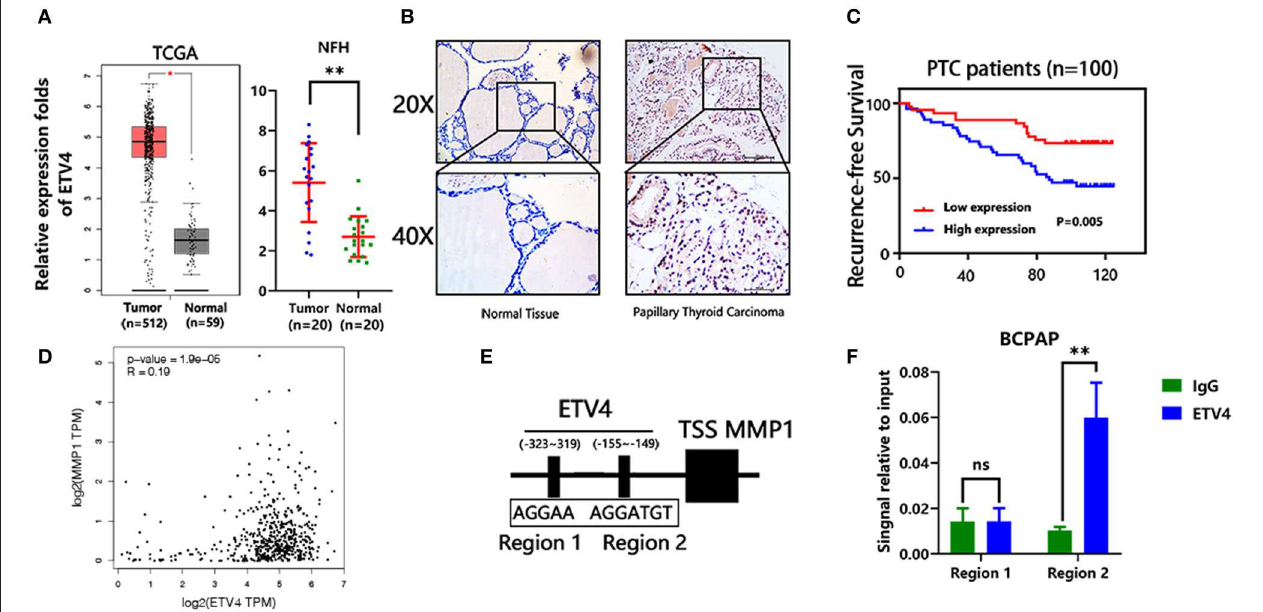
FIGURE 5 | ETV4 transcriptionally up-regulates MMP1 expression and correlates with PTC progression. (A) The mRNA expression level of ETV4 in the tumor ( n = 512) and normal ( n = 59) thyroid tissues from TCGA cohort (analysis generated from Gepia: http://gepia.cancer-pku.cn/). The mRNA expression level of ETV4 in the tumor ( n = 20) and normal ( n = 20) thyroid tissues from the NFH (Nanfang Hospital) cohort. (B) Representative IHC staining for ETV4 in PTC and normal tissue. ETV4 is mainly localized in PTC cell nucleus. (C) Kaplan–Meier survival analysis showing that higher ETV4 expression levels are significantly associated with poor recurrence-free survival in all PTC patients ( P = 0.005). (D) The association between mRNA expression level of ETV4 and MMP1 in the TCGA database (analysis generated from Gepia: http://gepia.cancer-pku.cn/). (E) Bioinformatic prediction of the binding sites of ETV4 within the promoter region of MMP1. (F) Chromatin immunoprecipitation analysis (all groups vs. IgG group) ( n = 3 independent experiments, Student’s t -test) of ETV4 binding to the MMP1 promoter. ** P <